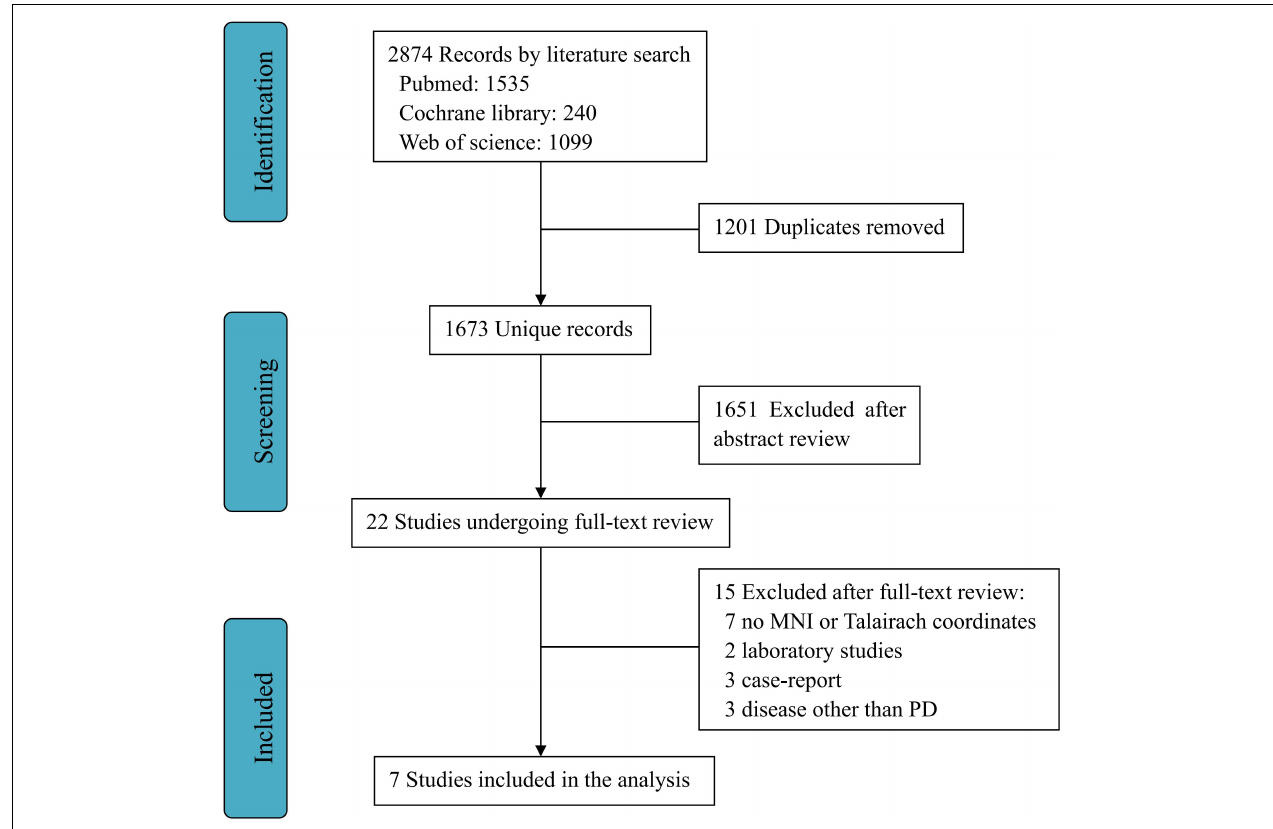
FIGURE 1 | Workflow for selection